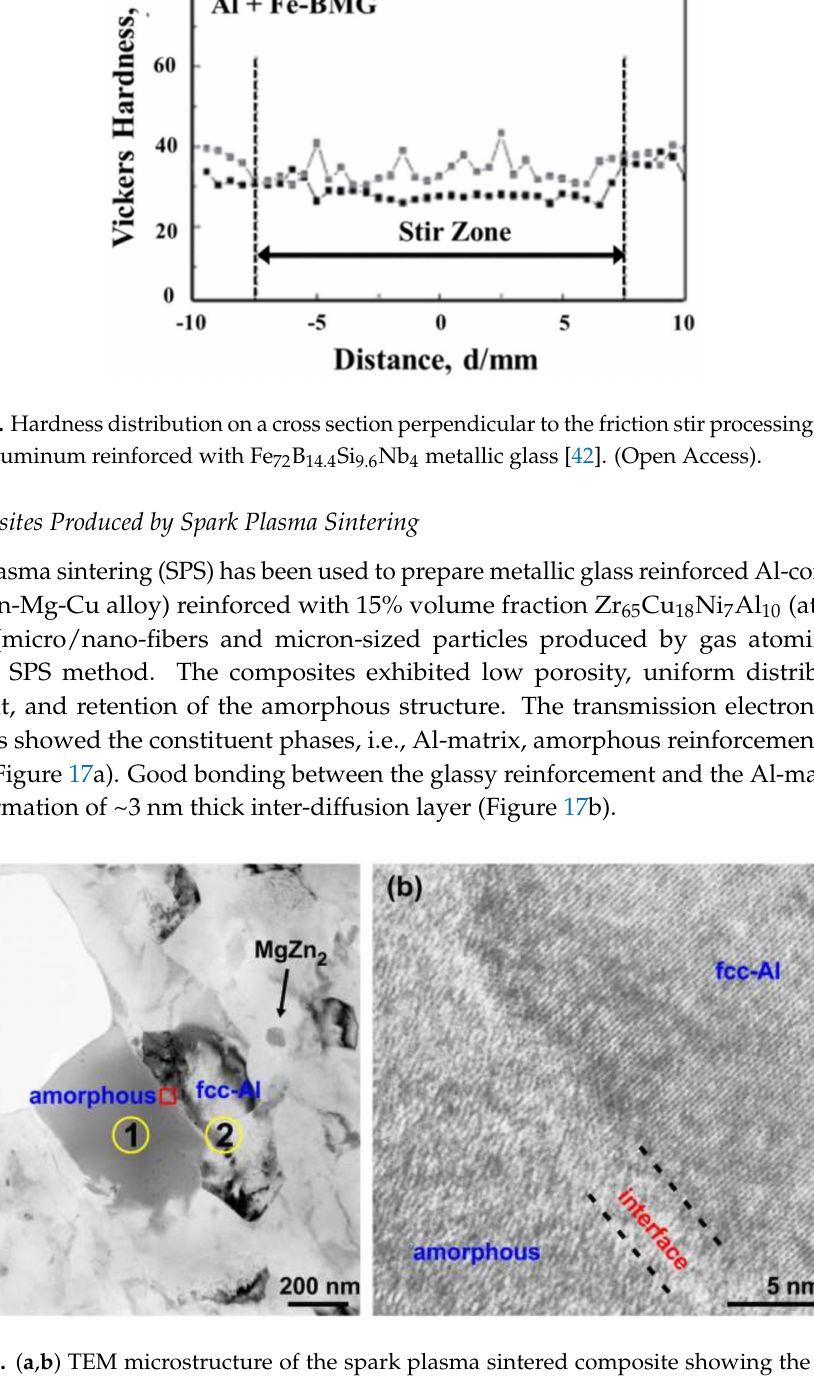
Figure 17. ( a , b ) TEM microstructure of the spark plasma sintered composite showing the interface between the metallic glass and the Al matrix [43]. (Open